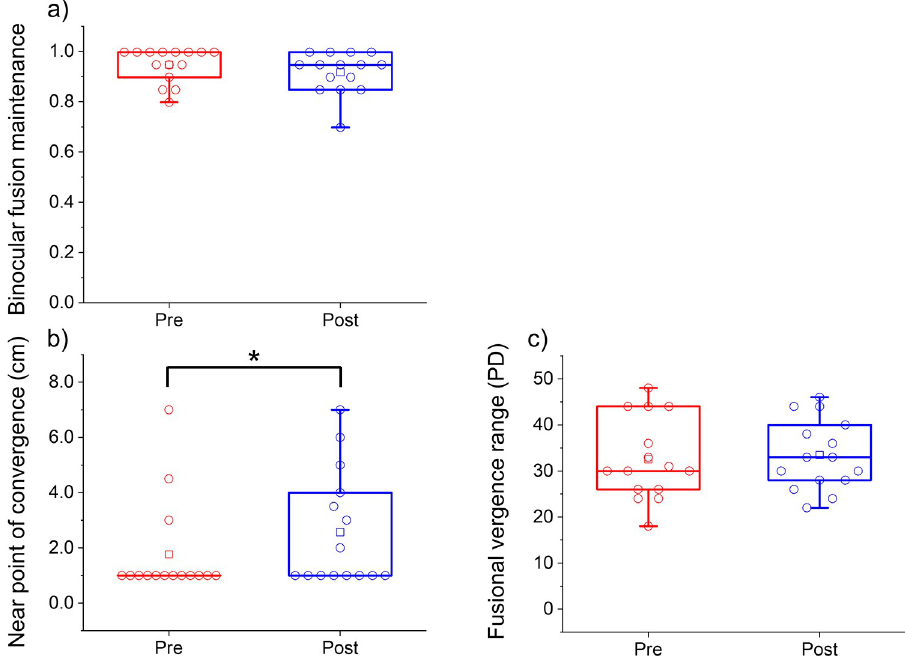
Fig 4. Binocular fusion maintenance (BFM) (a), near point of convergence (NPC) (b), and fusional vergence range (c) before (red) and after (blue) the visual task within the control group. The red and blue circles indicate individual BFM, NPC, and fusional vergence range values within the control group. The red and blue squares indicate the mean values for all the healthy volunteers. � P < 0.05, Wilcoxon signed-rank test.